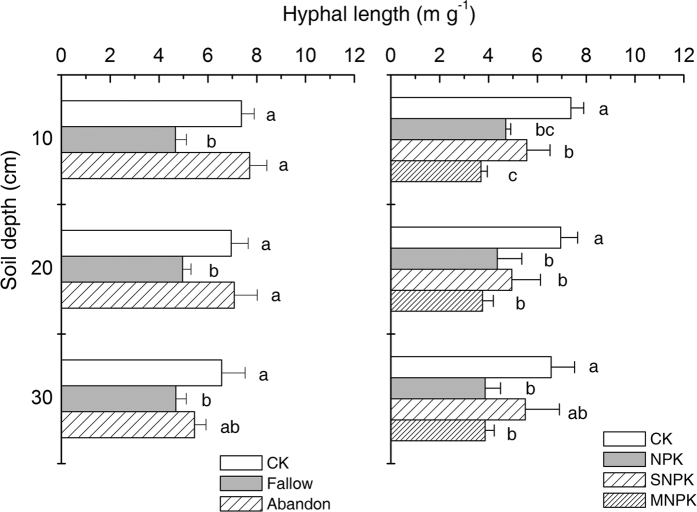
Hyphal length under contrasting soil management regimes (left panel) and fertilizer treatments (right panel).Error bars denote standard deviations (n = 3). Different small letters mean significant difference between treatments at a given soil depth at 0.05 (n = 3). Two-way ANOVA showed considerable effect of soil management regime (P = 0.000) and soil depth (P = 0.010), but no significant interaction between them (P = 0.077), on hyphal length, and the effect of fertilizer treatment (P = 0.000) and soil depth (P = 0.455) and their interaction (P = 0.846), respectively.